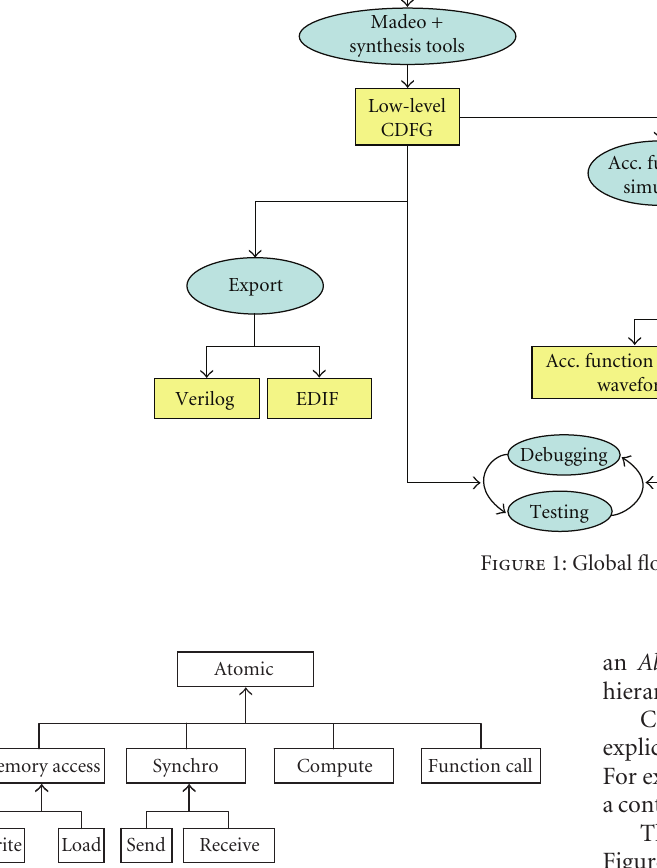
Figure 2: Atomic node inheritance tree in our CDFG model.